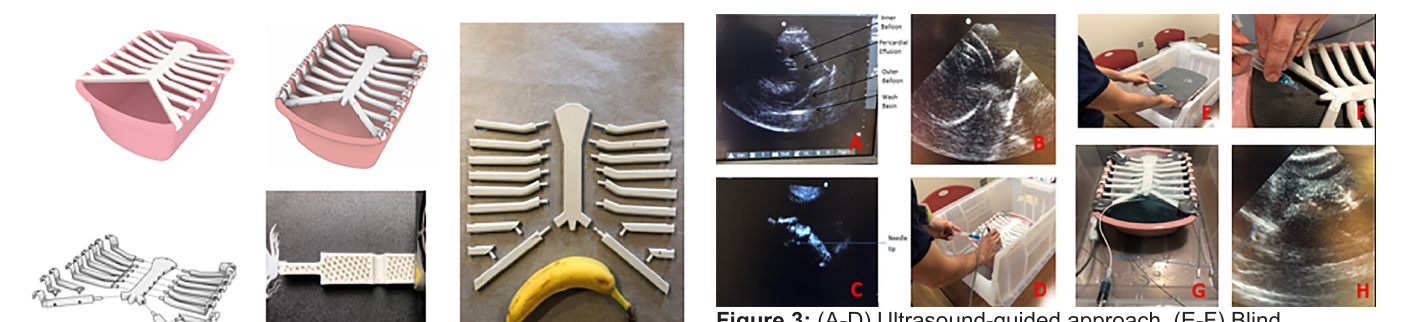
Figure 3: (A-D) Ultrasound-guided approach. (E-F) Blind approach. (G-H) Cannulation with pericardiocentesis